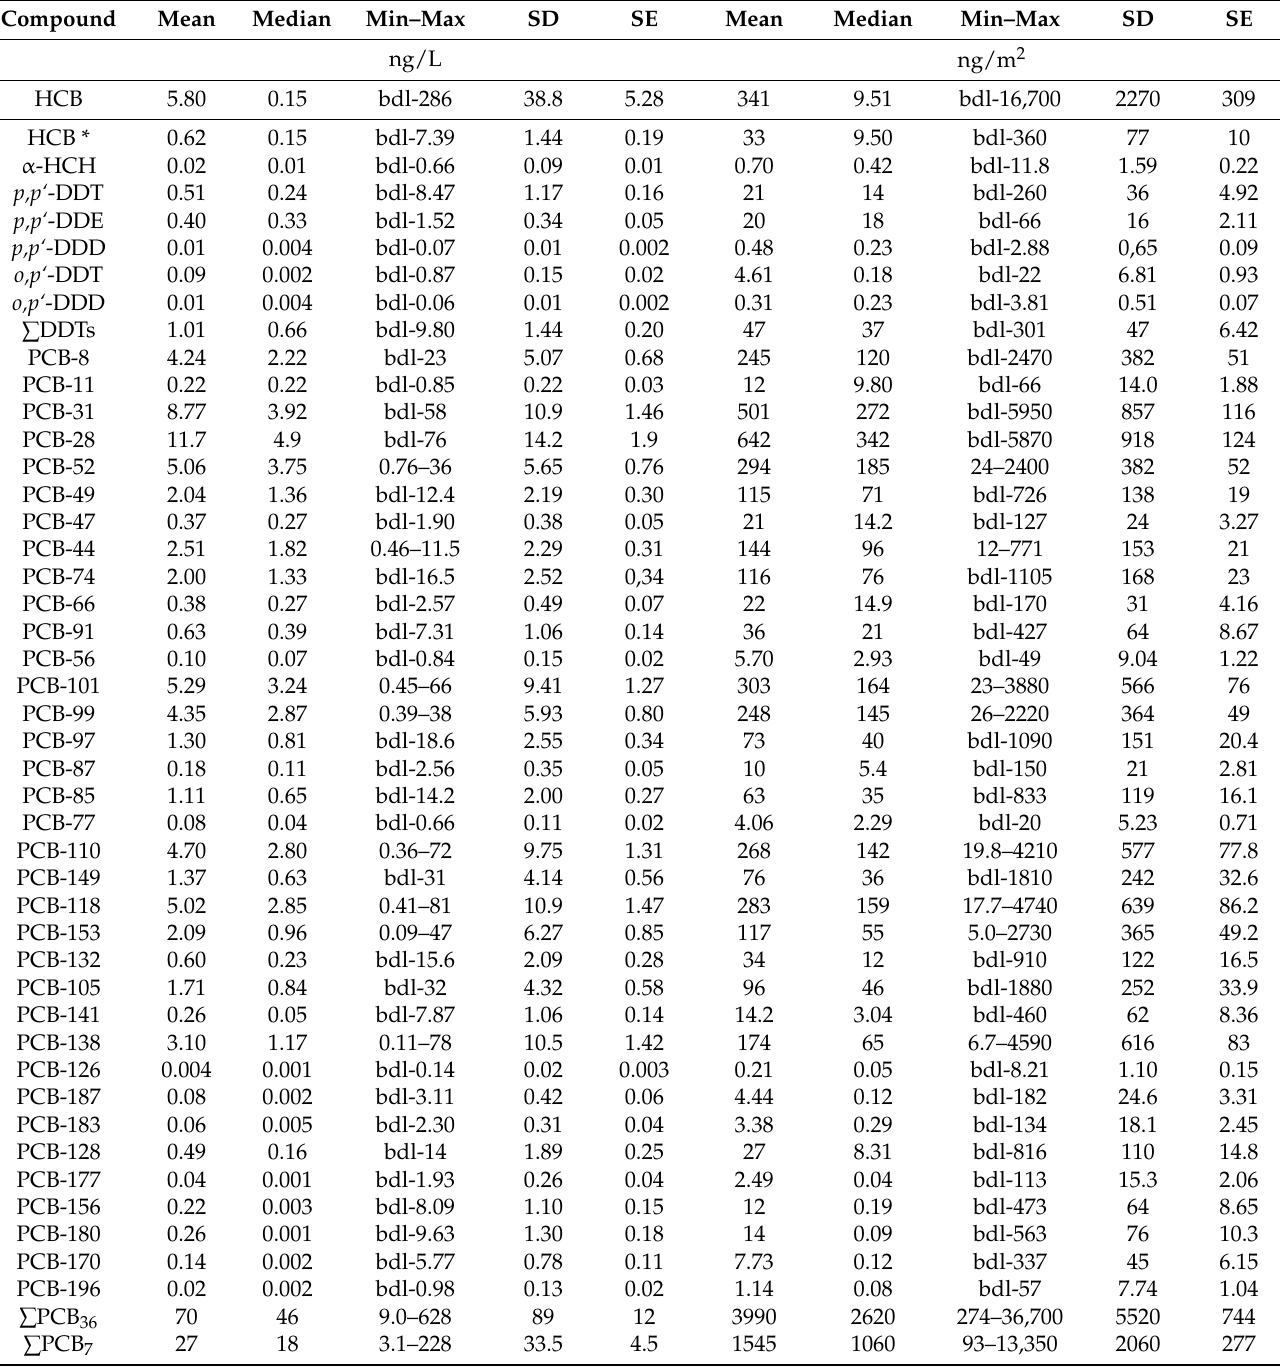
Table 1. The mean, median, range (min-max), standard deviation (SD), and standard error (SE) of organochlorines levels in snow found in 2021 (ng/L and ng/m 2